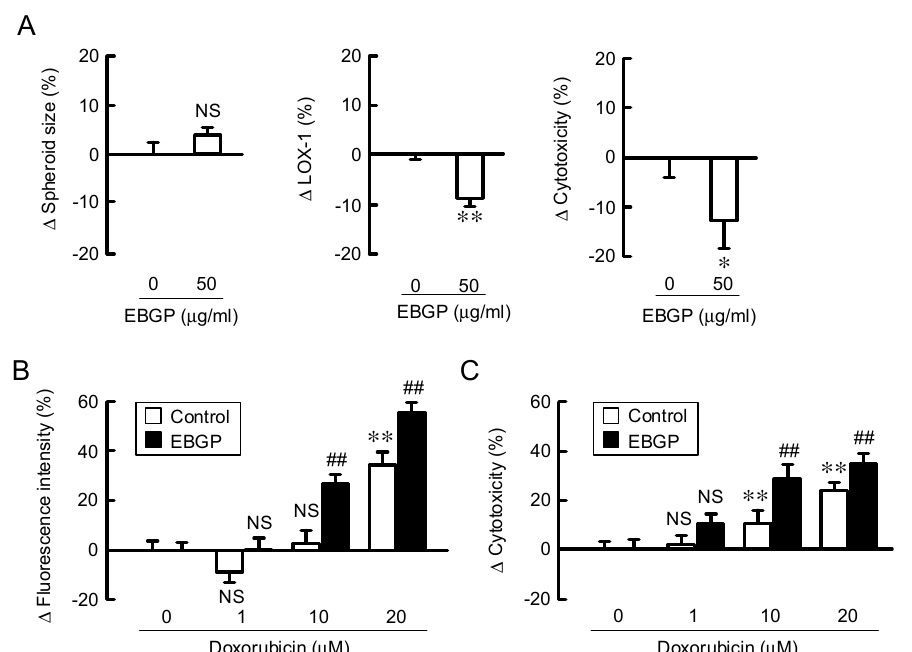
Figure 3. E ff ect of EBGP on the sensitivity to doxorubicin in the spheroids. ( A ) The spheroids were incubated in the absence and presence of 50 µ g of EBGP for 24 h. Spheroid size, fluorescence intensity of a hypoxia probe solution (LOX-1), and cell viability are represented as a percentage relative to 0 µ g / mL. ** p < 0.01, * p < 0.05, and NS p > 0.05 compared with 0 µ g / mL EBGP (Student’s t test). ( B ) The spheroids were pre-incubated with 50 µ g of EBGP for 24 h, followed by incubation with doxorubicin for 60 min. The fluorescence intensity of doxorubicin in the spheroids was examined using a BZ-X800 fluorescence microscopy. ( C ) After incubation of the spheroids with doxorubicin in the absence and presence of 50 µ g / mL of EBGP for 24 h, cell viability was measured using a CellTiter-Glo 3D Cell Viability Assay kit. The fluorescence intensity of doxorubicin and cell viability are represented as a percentage relative to 0 µ M doxorubicin. n = 3–6. ** p < 0.01 compared with 0 µ g / mL EBGP. ## p < 0.01 compared with control. NS p > 0.05 compared with 0 µ g / mL EBGP or control (Two-way analysis). Fluorescence intensity (F 1,31 = 145.43, p < 0.0001) and cytotoxicity (F 1,23 = 57.45.45, p < 0.0001).